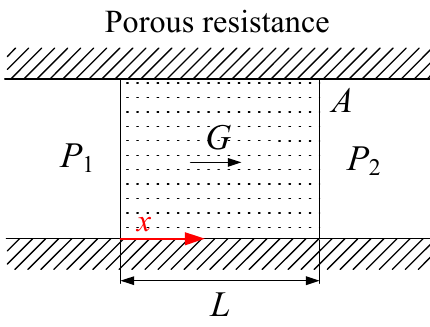
Figure 1. Schematic of flow through porous